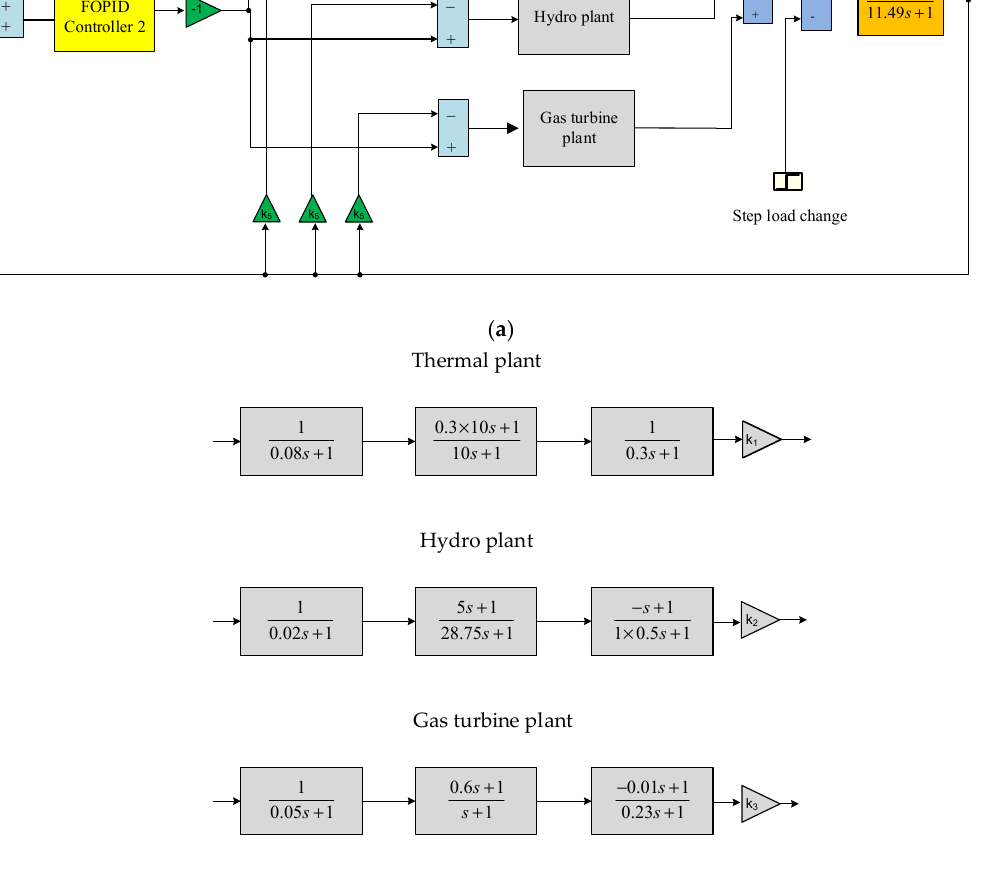
p K Figure 5. FOPID controller for the LFC analysis of the test system. ( ) ( )